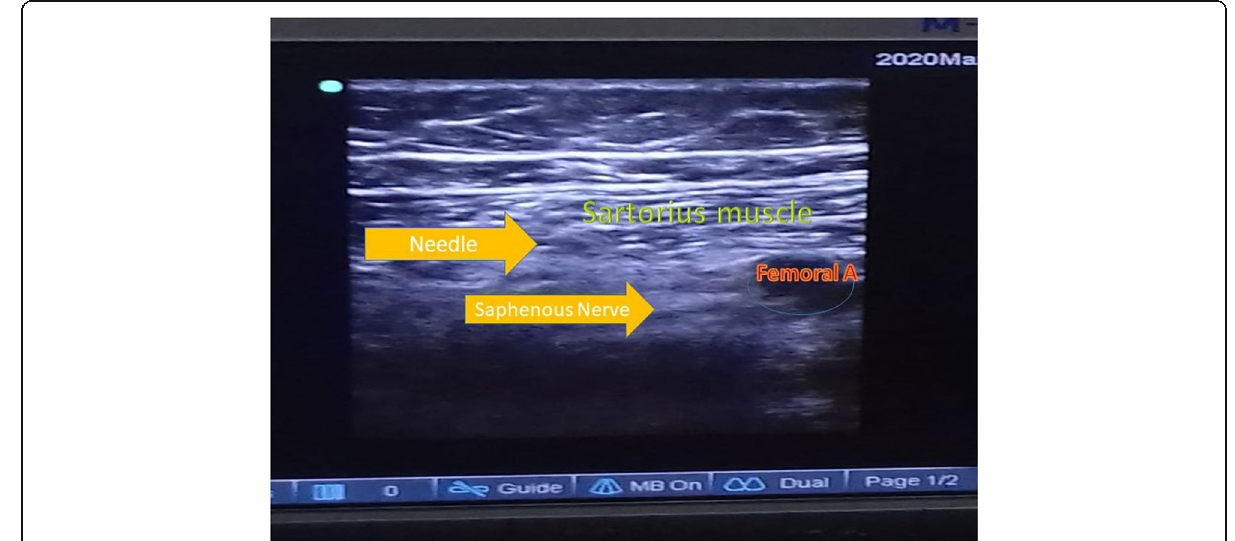
Fig. 1 In plane technique of adductor canal